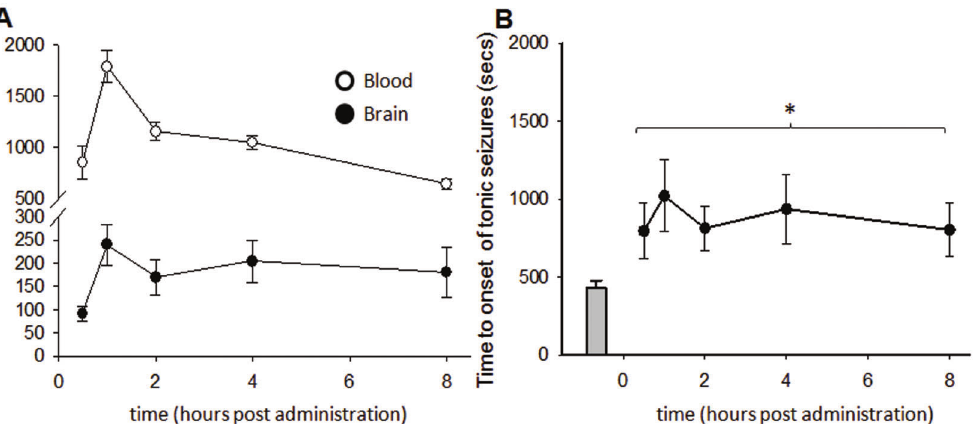
Figure 4. Brain levels of sEHI correlate with observed activity. The sEHI TUPS was administered at a single i.p. dose of 1 mg/kg and seizures were induced at varying times using s.c. PTZ procedure (n=8/time point). Following tonic hind limb extension and lethality, brains were rapidly excised and TUPS was quantified by LC-MS/MS. Protected animals (3 of 8 in each group) were sacrificed 30 min following PTZ treatment and are included on the left panel. (A) TUPS was well absorbed and blood and brain inhibitor levels reached well over in vitro IC 50 values within an hour and remained relatively stable over 8 h. (B) The efficacy of TUPS was significantly correlated with brain inhibitor levels (Spearman’s Rho, 0.90, p=0.037) All time points are significantly different from the vehicle treated animals (One Way ANOVA, p=0.034).